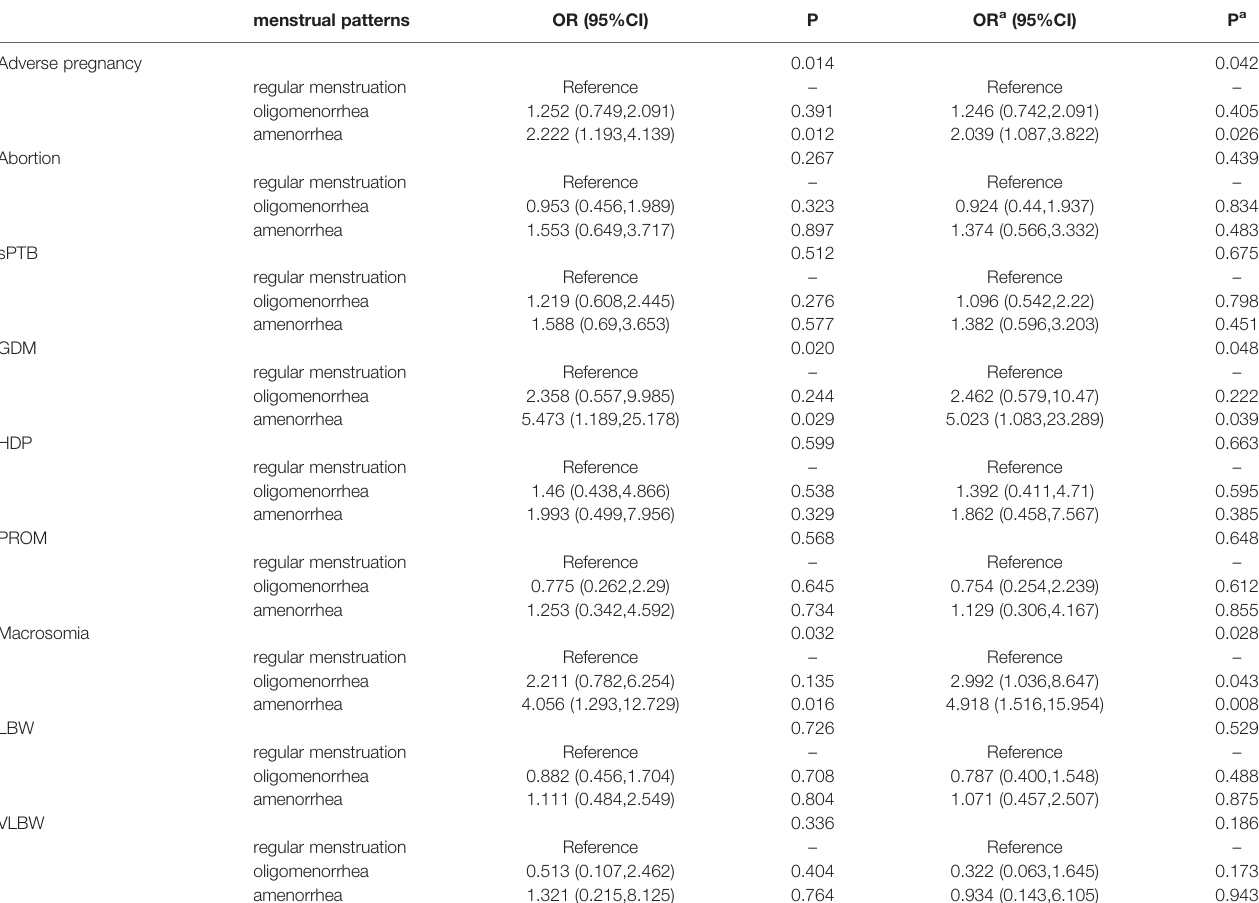
TABLE 3 | Logistic regression analysis of maternal and perinatal